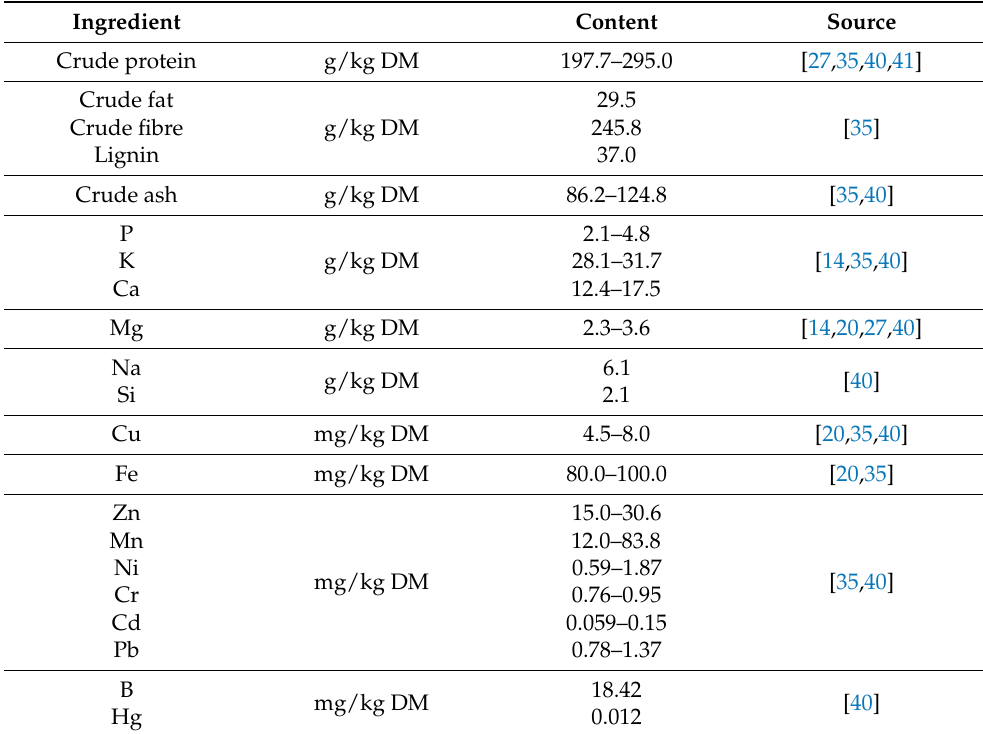
Table 2. Chemical composition of fodder galega ( Galega orientalis